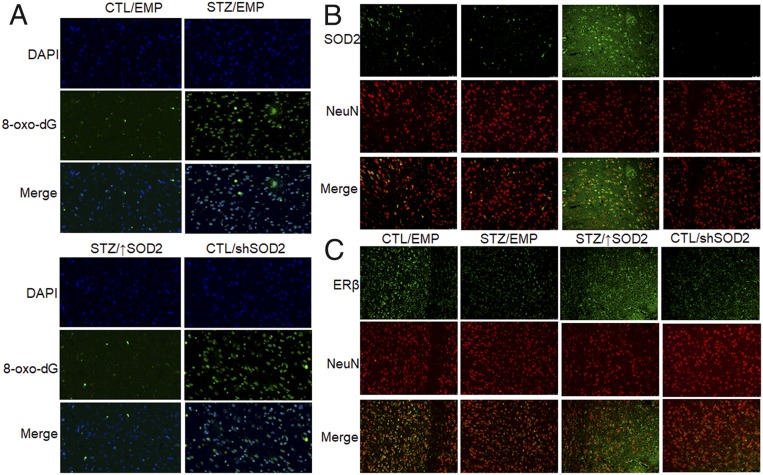
Immunohistochemistry staining of amygdala. The 6-wk-old male offspring from either the control (CTL) or maternal diabetes (STZ) groups received empty control (EMP), SOD2 overexpression (↑SOD2), or SOD2 knockdown (shERβ) lentivirus infusion. Then, the offspring at 8 wk old were sacrificed, and the amygdala was isolated for immunohistochemistry staining. (A) The 8-oxo-dG staining for oxidative stress (green) and DAPI staining for nuclei (blue). (B) SOD2 staining (green) and NeuN staining for neurons (red). (C) ERβ staining (green) and NeuN staining for neurons (red). (Magnification, 100×.)